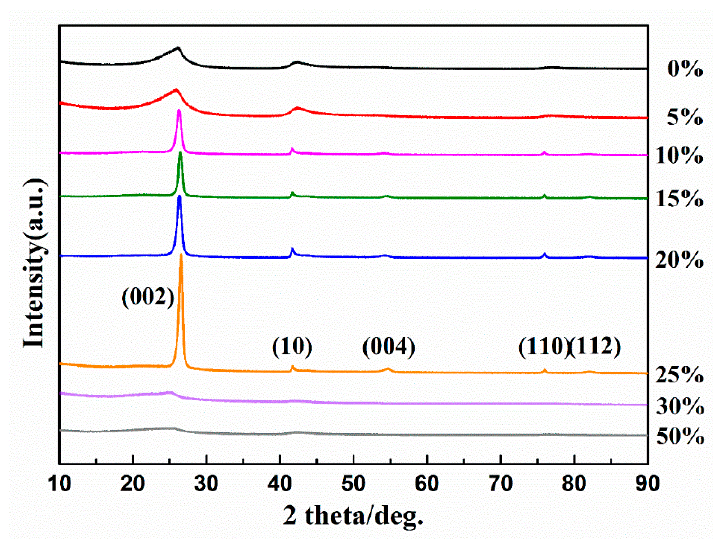
Figure 3. X-ray di ff raction (XRD) patterns of BN-Si 3 N 4 composite ceramics with various Si 3 N 4 contents,